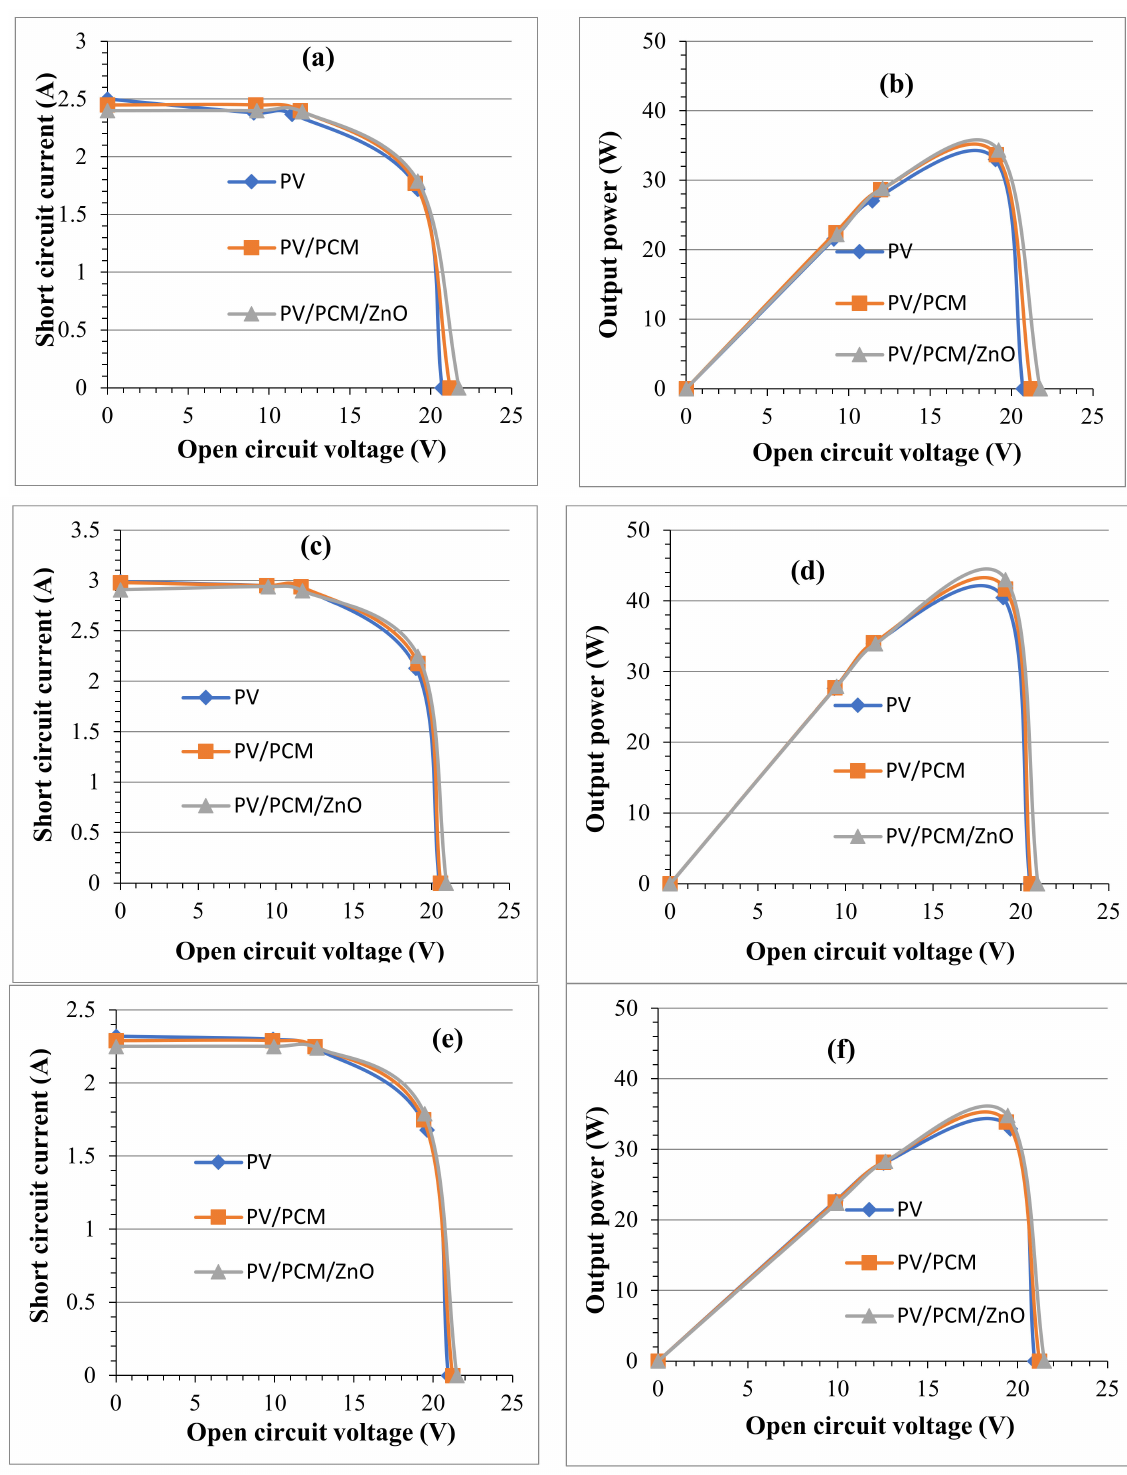
Figure 4. Plots of I-V curves ( a , c , e ) and variation of power outputs ( b , d , f ) for the PV systems in the presence and absence of PCM and ZnO-doped PCM at 10:00 a.m. ( a , b ), 12:00 p.m. ( c , d ), and 3:00 p.m. ( e , f